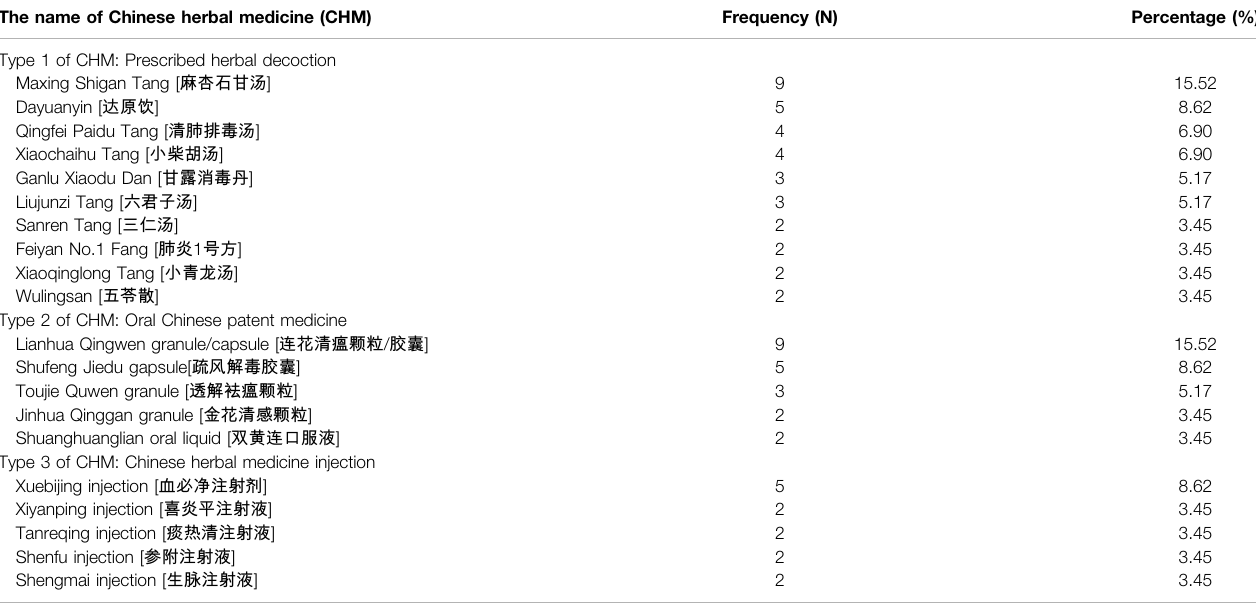
TABLE 2 | Chinese herbal medicine used twice or more frequently. The name of Chinese herbal medicine (CHM)